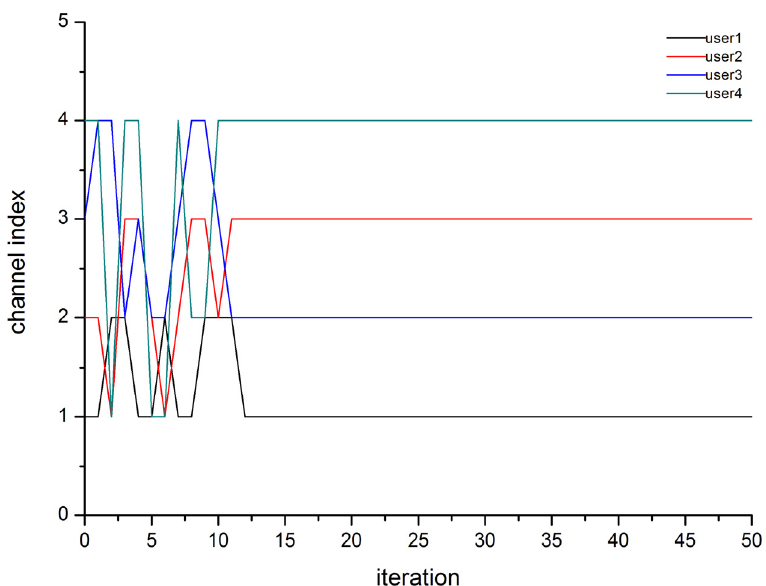
Figure 7. The simulation results of proposed CR spectrum allocation algorithm based on non-cooperative game theory with four channels.